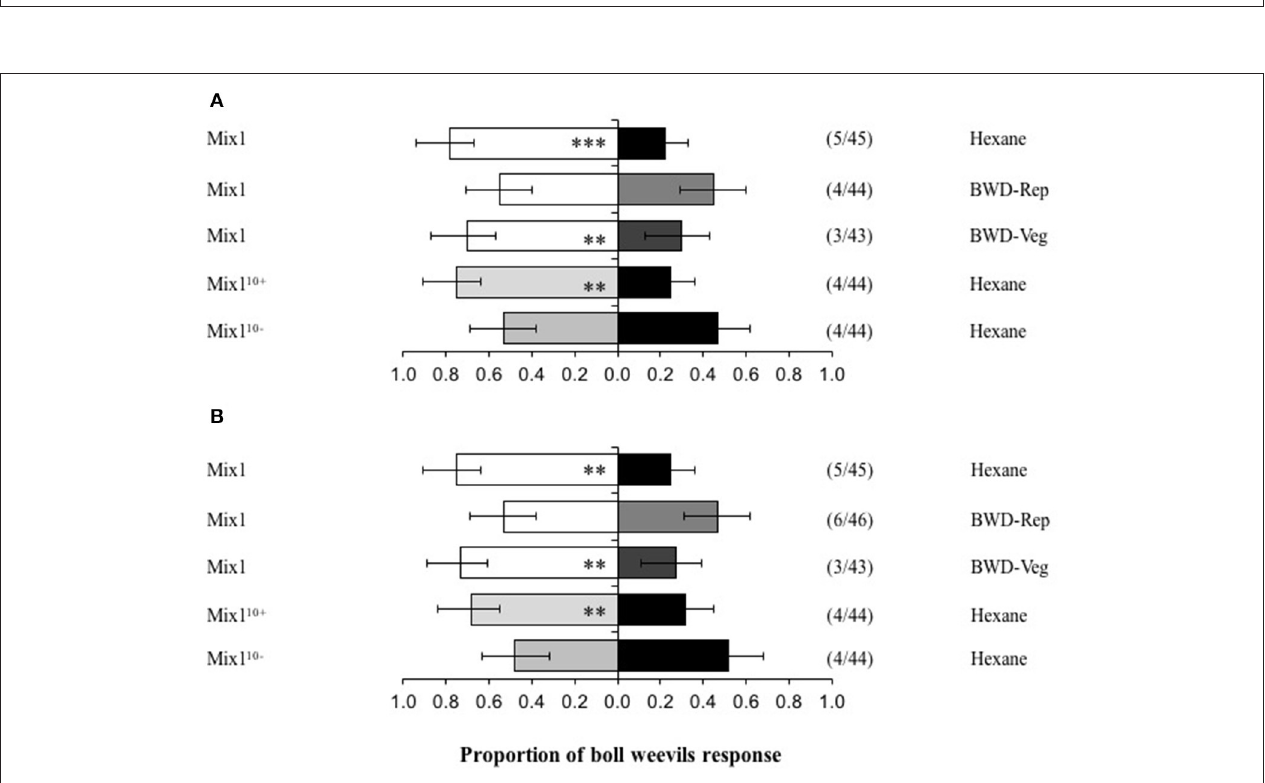
FIGURE 4 | First choice of male (A) and female (B) boll weevils, Anthonomus grandis, in a Y-tube olfactometer. Mix1 = synthetic blend at the same concentration and ratio as found in the volatile samples collected from boll weevil-damaged cotton plants at the reproductive stage; Mix1 10 + = Mix1 × 10 concentrated; Mix1 10 − = Mix1 × 10 diluted; BWD-Rep = volatile samples collected from boll weevil-damaged cotton plants at the reproductive stage; BWD-Veg = volatile samples collected from boll weevil-damaged cotton plants at the vegetative stage. Asterisks indicate differences (**0.01 > P > 0.001, *** P < 0.001) between pairs of treatments. Bars indicate 95% of confidence interval. Numbers in parentheses indicate insects that did not respond to either tested treatments/total amount of bioassays.